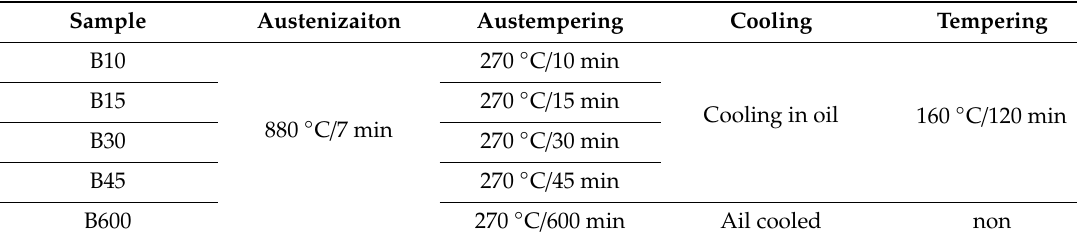
Table 1. Heat treatments regimes of the steel in the present study.